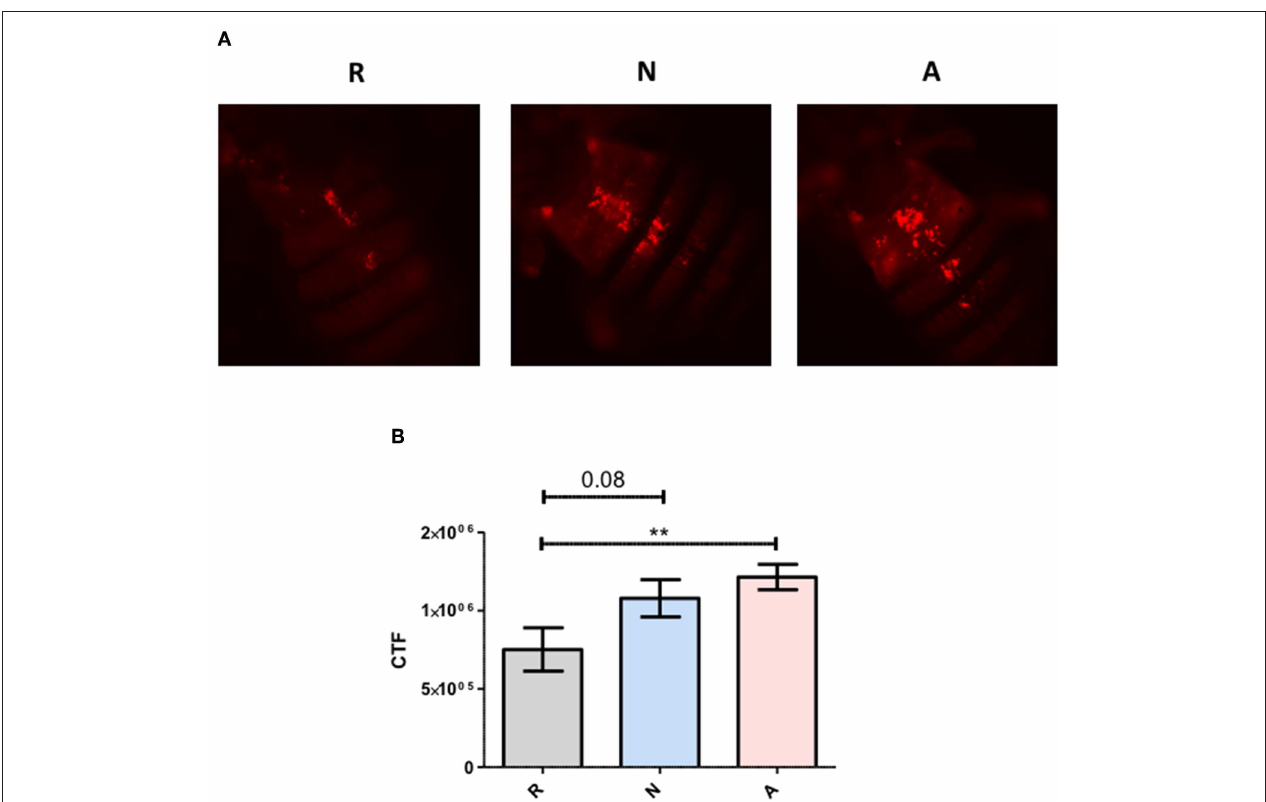
FIGURE 9 | Heterorhabditis bacteriophora nematode activated Excreted/Secreted (ES) products provoke a stronger phagocytic response. Adult Drosophila melanogaster were injected with 69.0 nl of a 1:4 mixture of 4 mg/mL pHrodo E. coli conjugates and activated ES products (A), non-activated ES products (N), or Ringer’s buffer (R). (A) Images were captured by fluorescence microscopy at 10x magnification and (B) the area associated with pericardial nephrocytes was analyzed with ImageJ software. Values are shown for measurements collected over three trials of three replicates each (** p <